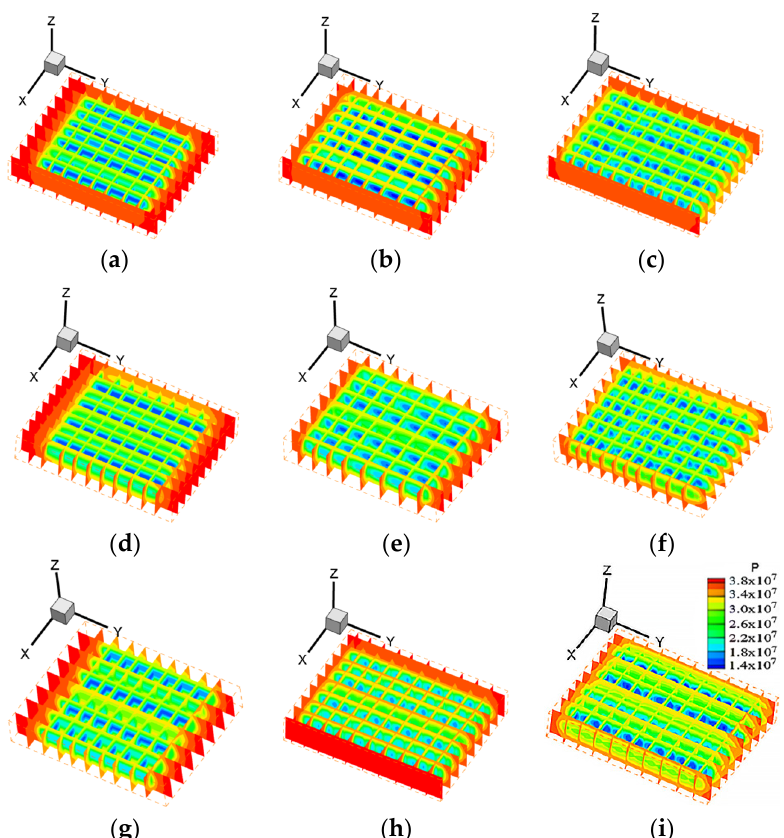
Figure 10. Horizontal well pressure distribution field diagram after different development schemes.( a ) scheme 1; ( b ) scheme 2; ( c ) scheme 3; ( d ) scheme 4; ( e ) scheme 5; ( f ) scheme 6; ( g ) scheme 7; ( h ) scheme 8; ( i ) scheme 9.